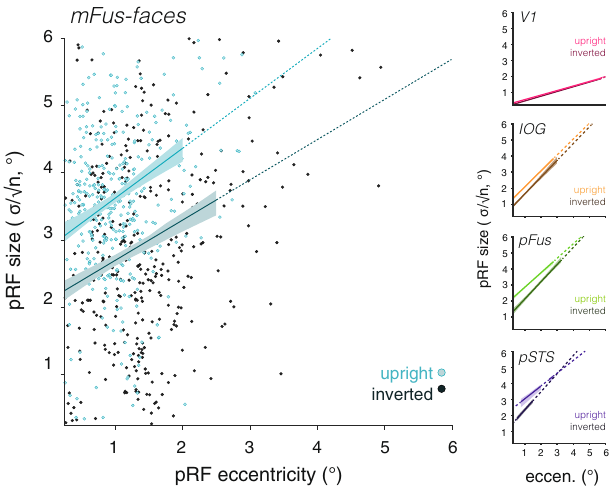
Fig. 3 Face inversion yields smaller pRFs in face-selective regions across eccentricities. Scatterplots showing the relationship between pRF size and pRF eccentricity for voxels in each ROI, mapped with upright faces (light colors) and inverted faces (dark colors). This relationship is summarized by the line of best- fi t across all voxels pooled over participants with model goodness-of- fi t R 2 > .5. Shaded region: a bootstrapped 68% con fi dence interval at 0.25° wide bins for which there were more than 20 voxels across participants. Dashed lines: bins for which there were fewer than 20 voxels across participants. Dots: a random sample of 300 mFus-faces voxels across participants. See also Supplementary Fig. 3.